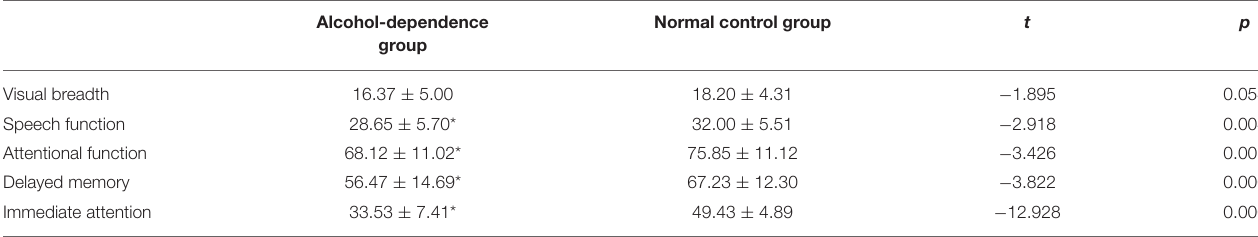
TABLE 2 | Comparison of the original score in RBANS (mean ± SD).